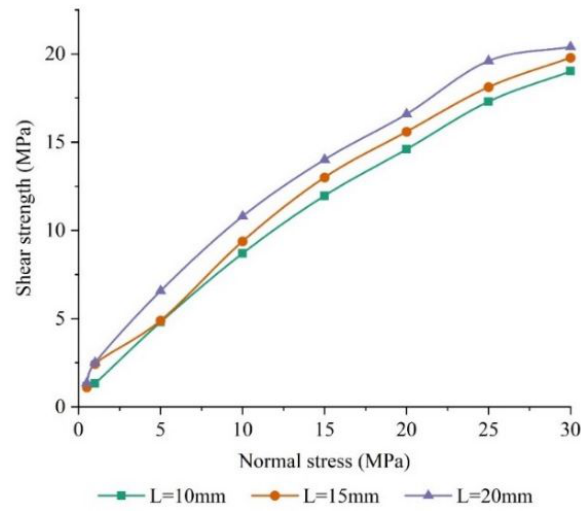
Figure 11: Relationship between shear strength and normal stress under different saw-tooth widths